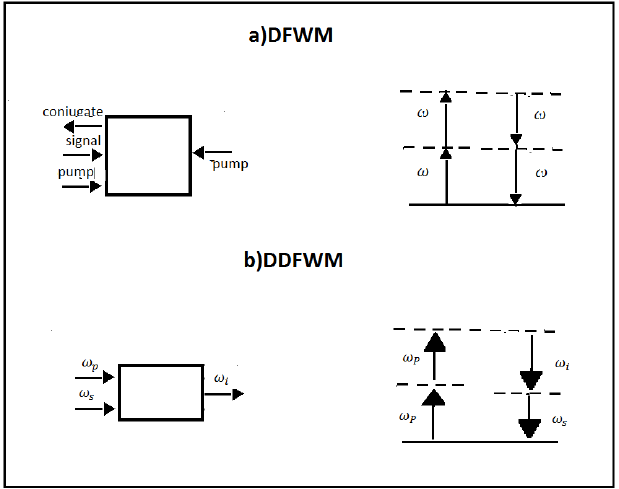
Figure 4. ( a ) Degenerate FWM and ( b ) dual degenerate FWM. On the left are the geometries of the interactions, and on the right are the energy level diagrams describing the interactions.